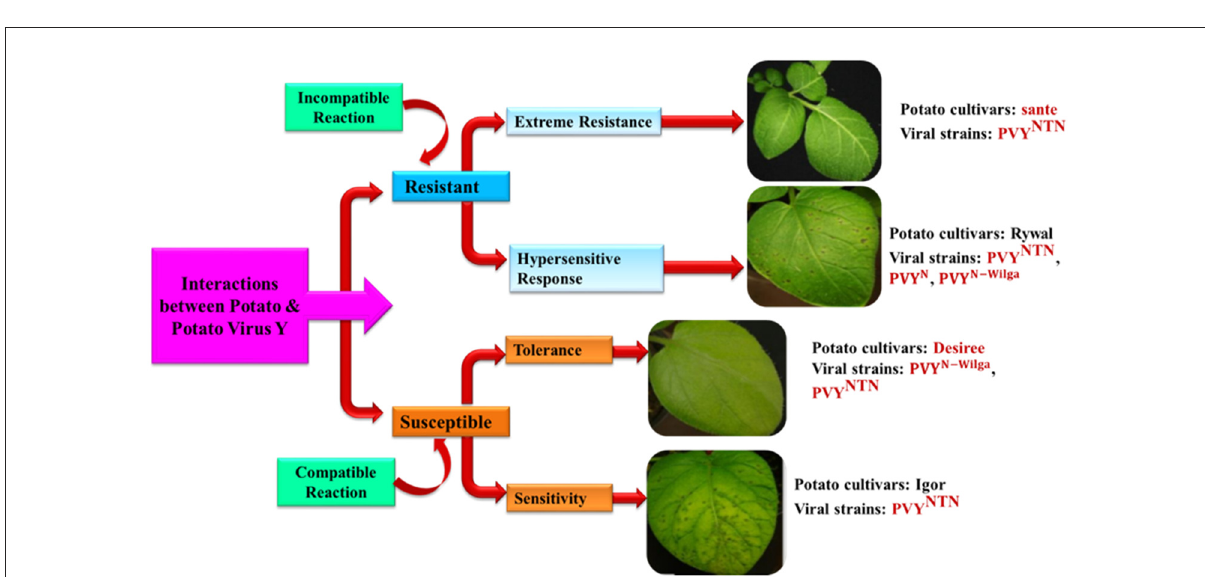
FIGURE3 Interaction between potato and Potato Virus Y depicting incompatible and compatible resistance and susceptibility reaction in different potato varieties. Differential reactions (Extreme resistance, hypersensitive resistance, tolerance and sensitivity) are determined by the host genotype, viral strain, and environmental factors, and appear as varied responses in terms of virus replication and disease morphologies. Images representing symptoms on leaves 6 days after inoculation in selected cultivars of potato in optimum environment condition (Modified from Baebler et al.,